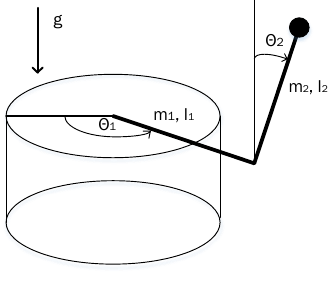
Fig. 3. Single-pivot rotating inverted pendulum